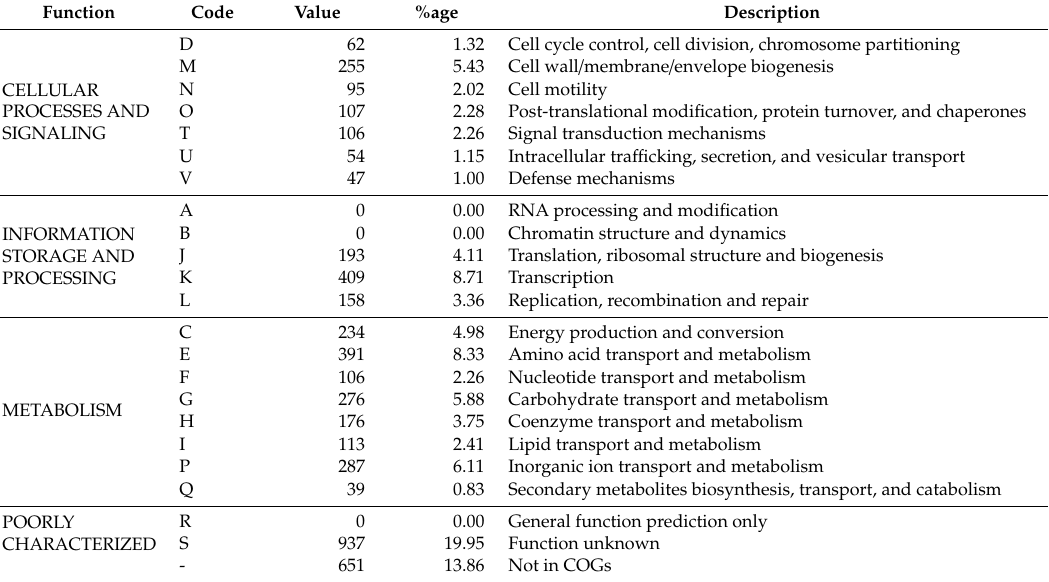
Number of genes associated with general Clusters of Orthologous Groups (COG) functional